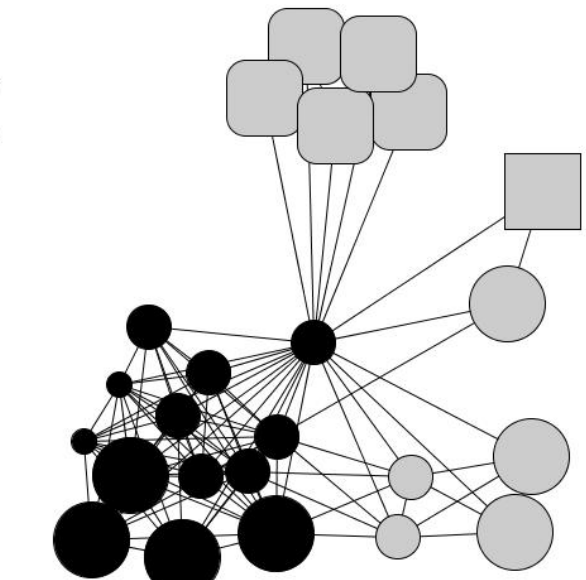
Figure 1. Laureano’s personal network. Node color indicates the type of relationship: family members (black), friends and acquaintances (gray), and professionals (white). Node size indicates ego’s perception of alter’s status: big (ego perceives that “alter has a better socioeconomic situation than me”), average (ego perceives that “alter has a similar situation as me”) and small (ego perceives that “alter has a worse socioeconomic situation than me”). Node shape indicates the length of the relationship: a triangle (less than 1 year of relationship), a square (between 1 and 5 years of relationship), a rounded rectangle (more than 5 years), and a circle (lifetime).